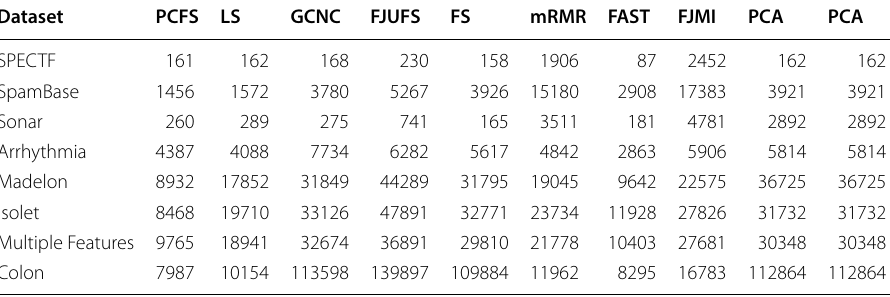
Table 7 Average execution time (in ms) of different feature selection methods over ten independent